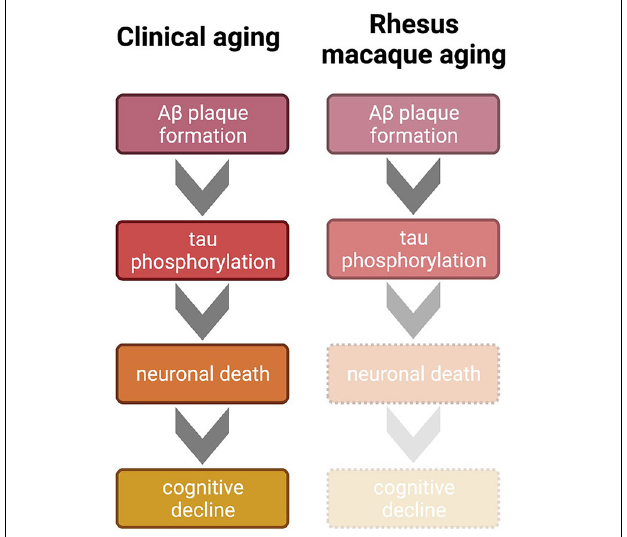
FIGURE 2 | Comparison of clinical and non-human primate progression of brain aging according to the generally accepted amyloid cascade hypothesis of AD. Clinically, A β aggregates and triggers hyperphosphorylation of tau. This tauopathy accumulates intracellularly to lead to neuronal death, which is a primarily proposed mechanism of cognitive decline. Mid to late stages of AD result in the full clinical cascade visualized on the left. However, even in the oldest known rhesus macaques, this trajectory is incomplete; A β plaques and tauopathy do not reach levels seen in the clinical AD cases. Therefore, because tauopathy only reaches early stages of phosphorylation, cell death and the subsequent sharp cognitive decline are absent in the monkey model, which renders the rhesus macaque more suitable for naturally modeling normative clinical brain aging or early stages of AD. Figure created with